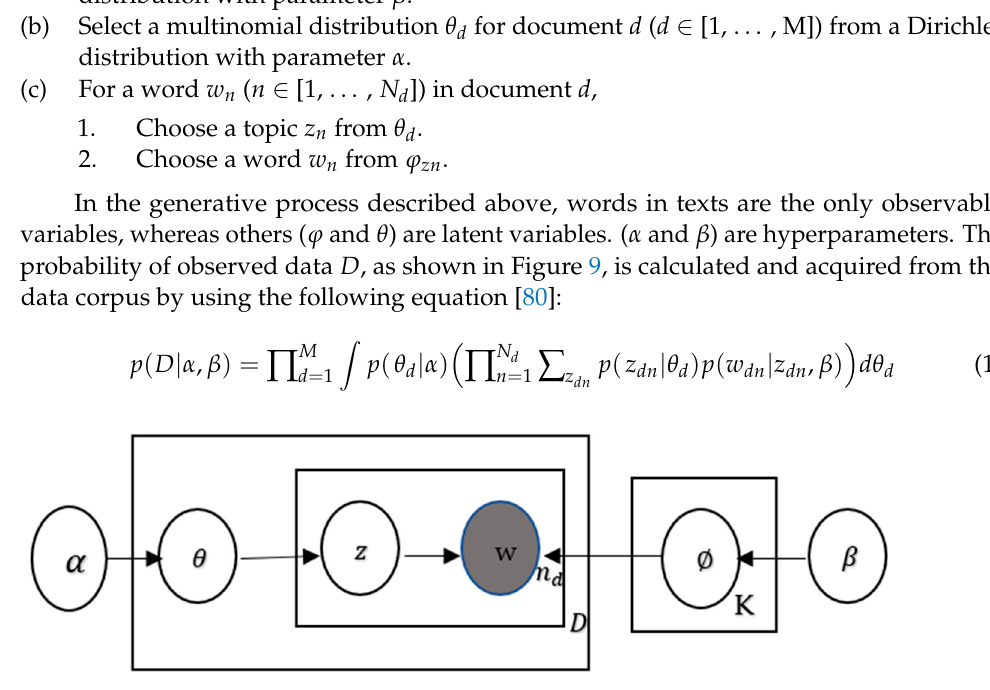
Figure 9. Graphical illustration of LDA.